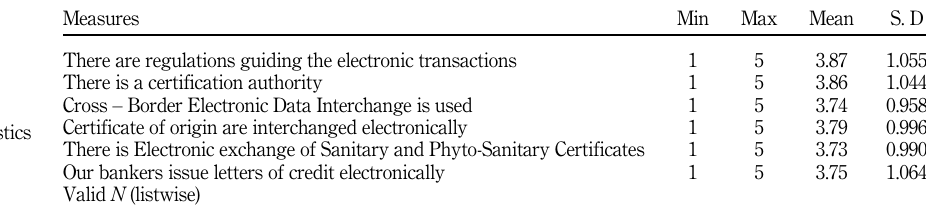
on the extent of paperless port